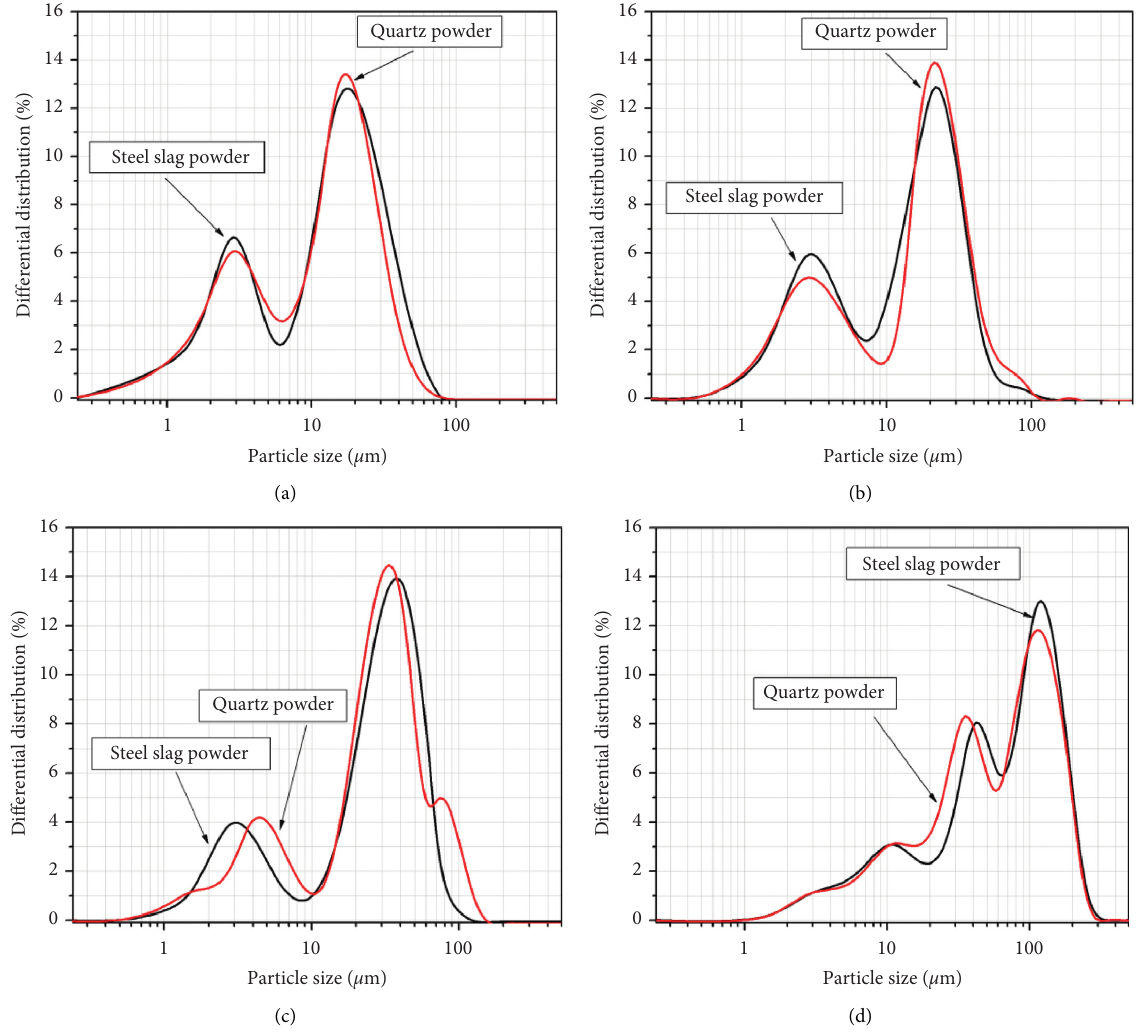
Figure 2: Particle size distributions of steel slag and quartz powder. (a) R 1. (b) R 2. (c) R 3. (d) R 4. Table 3: Mixing proportions of blended cements containing different amounts of steel slag powder.